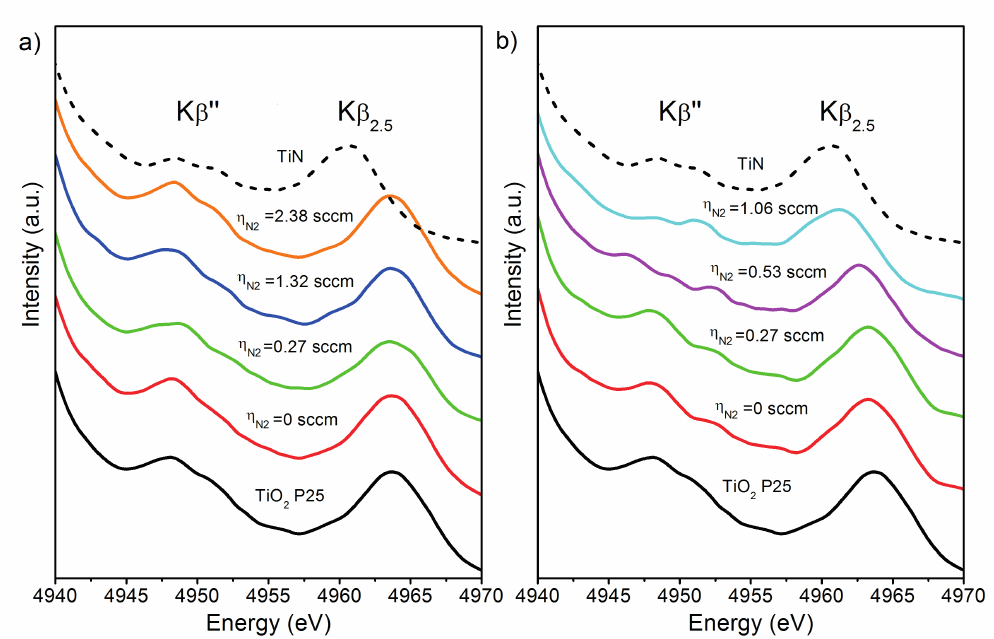
:N (I/I =0.13) and b) non-stoichiometric 2 0